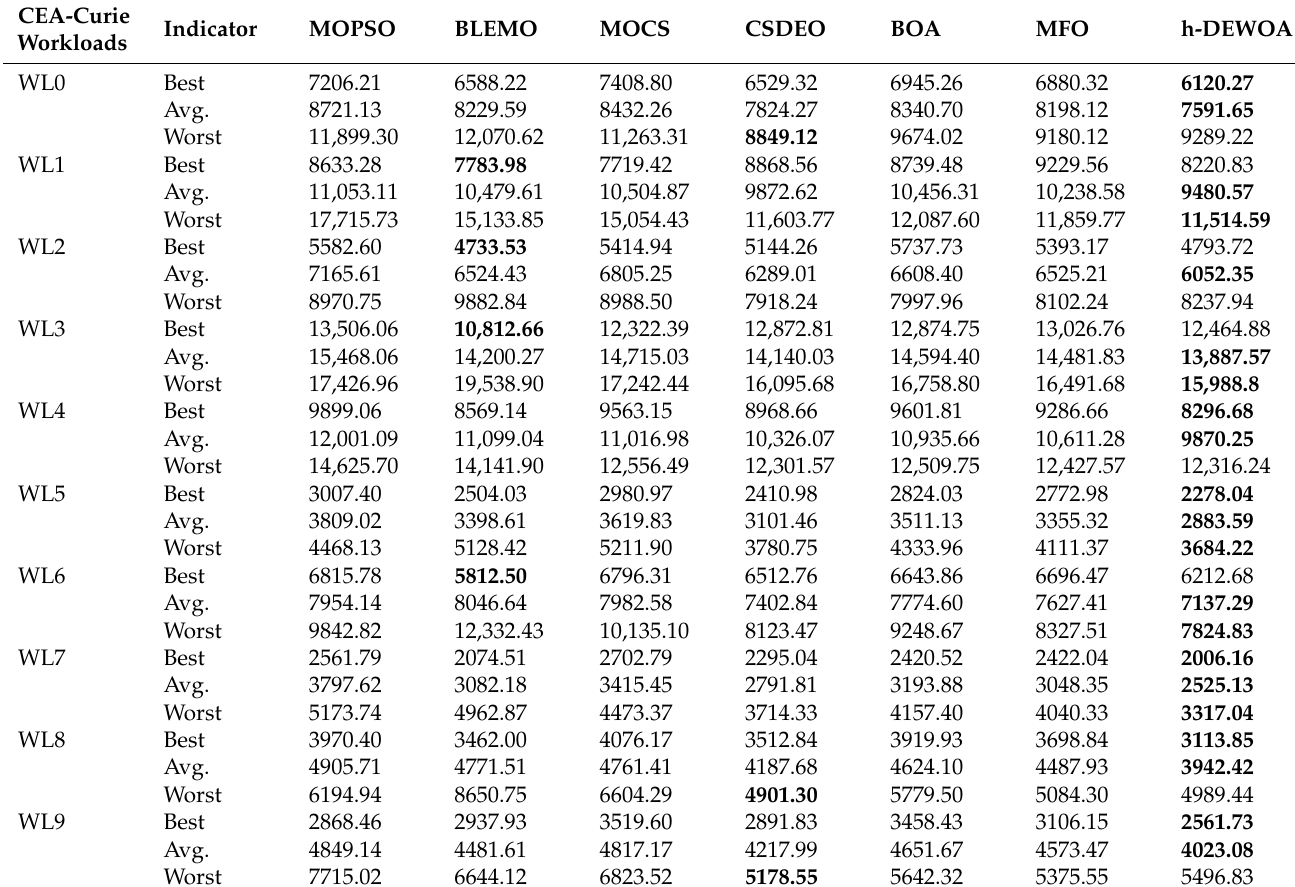
Table 15. Energy consumption statistical results for WL0–WL9